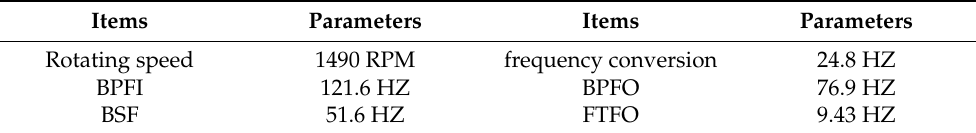
Figure 8 is the original signal time-domain diagram and partially enlarged diagram.